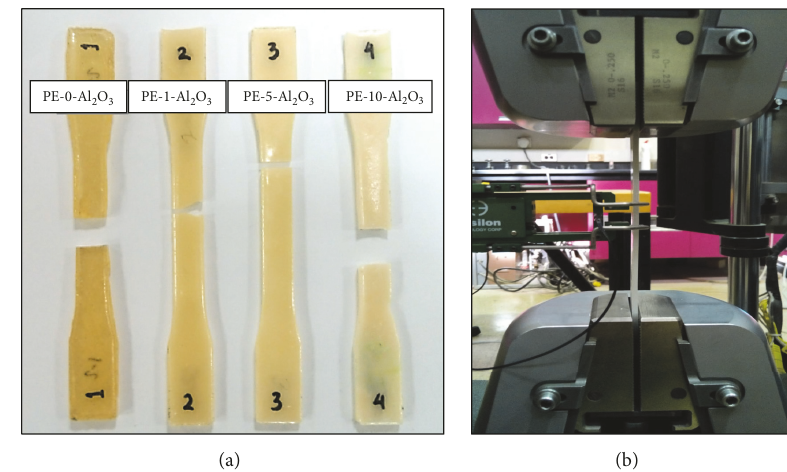
Figure 2: (a) Composites samples after tensile test; (b) tensile testing setup.